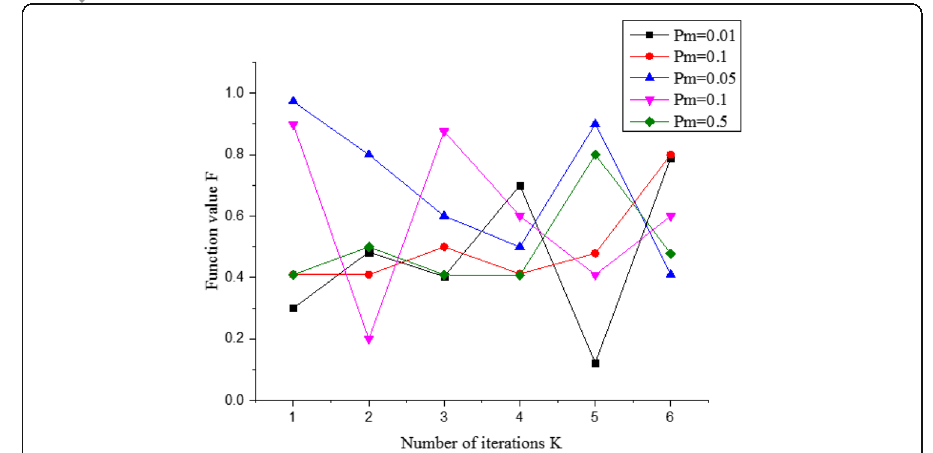
Fig. 6 The convergence graph of the algorithm under different values of